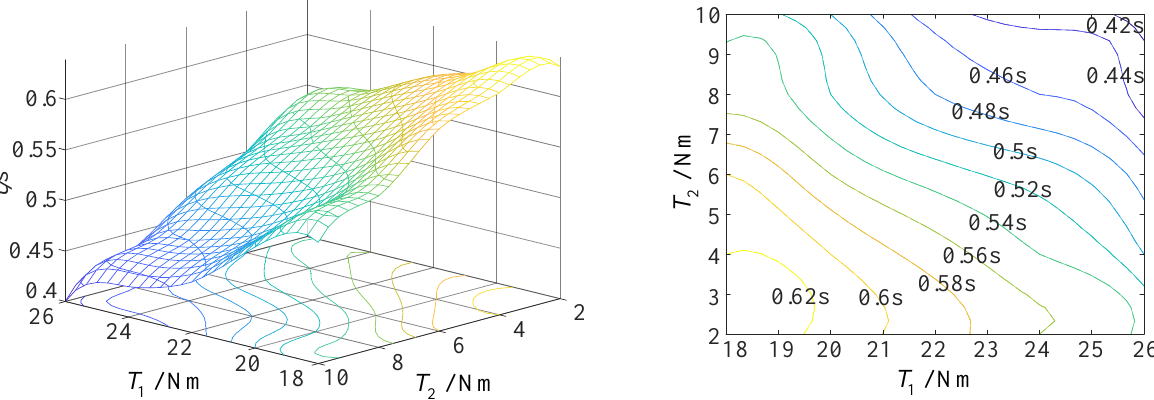
Figure 15. The curve of driving torque and deployment time of folding wing at an airspeed of 40 m/s (synchronous deployment mode).